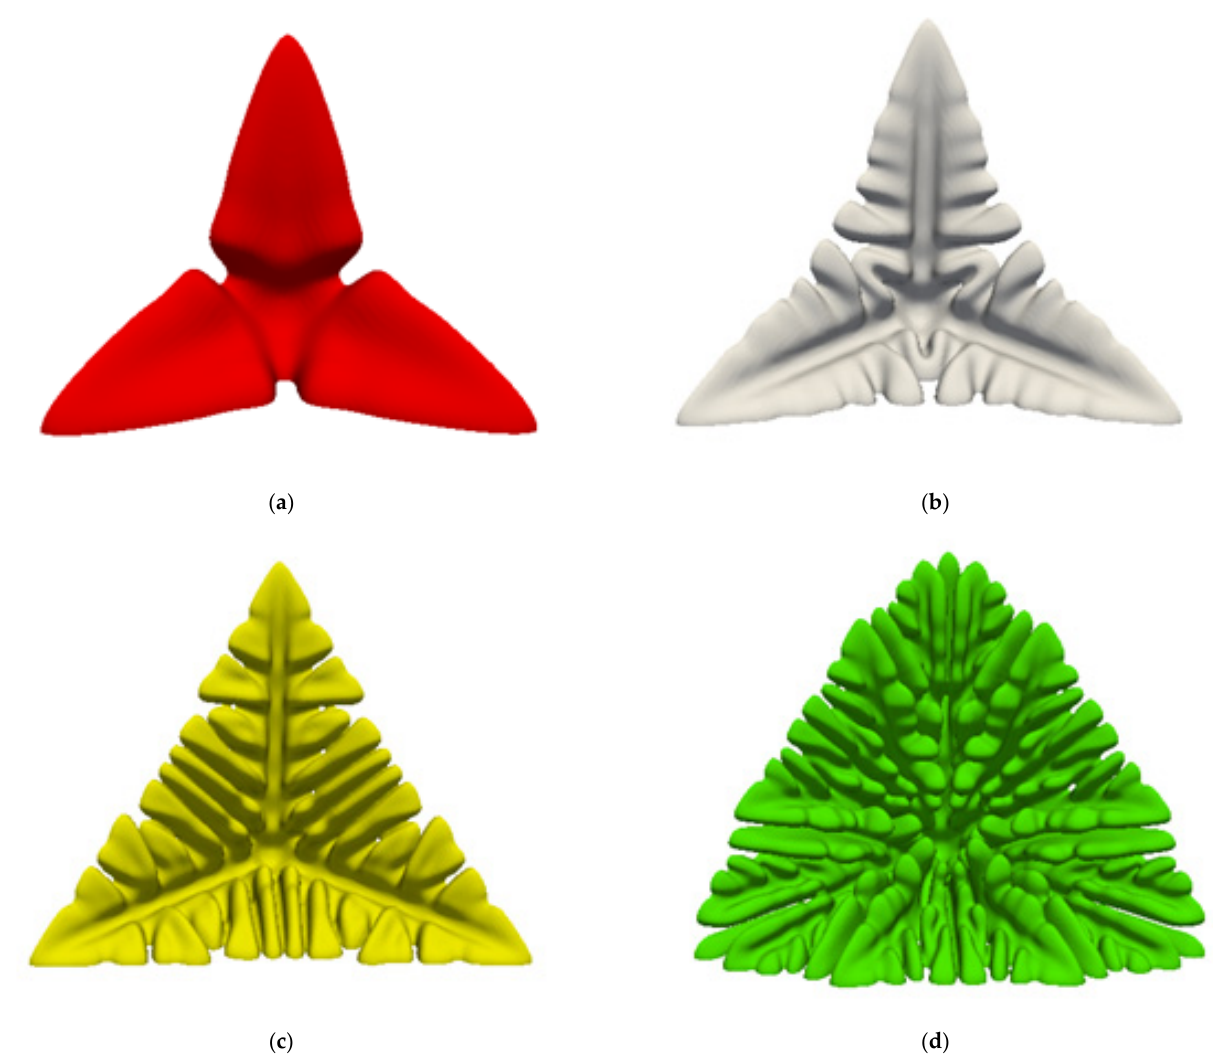
Figure 2. Morphology of dendrite growth under different supersaturation when the length is 8000. ( a ) Ω = 0.35 ; ( b ) Ω = 0.45 ; ( c ) Ω = 0.50 ; ( d ) Ω = 0.55 .